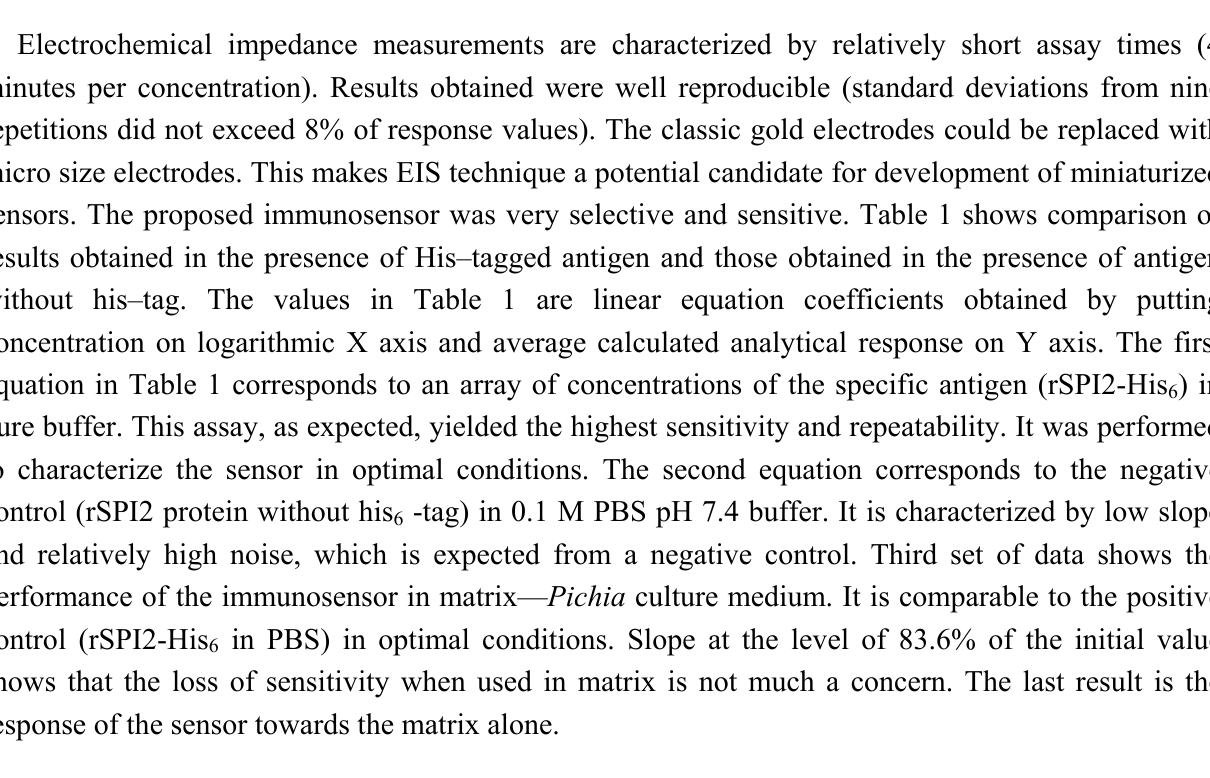
Table 1. EIS responses of the immunosensor incorporating Anti-His IgG F(ab’) fragment in PBS buffer pH 7.4 and in the presence of Pichia pastoris culture towards rSPI-His 6 medium. Control samples: protein rSPI2 in PBS and medium